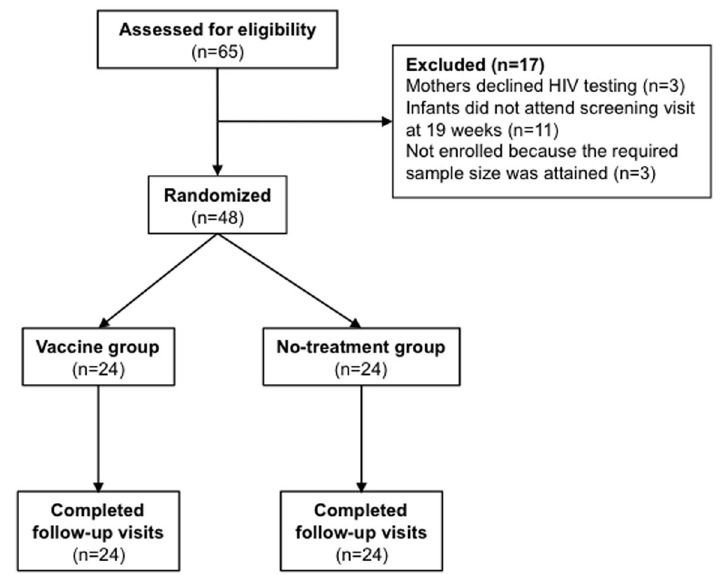
Figure 2. Trial Profile. Diagram indicating the numbers of infants screened and followed up throughout the study.